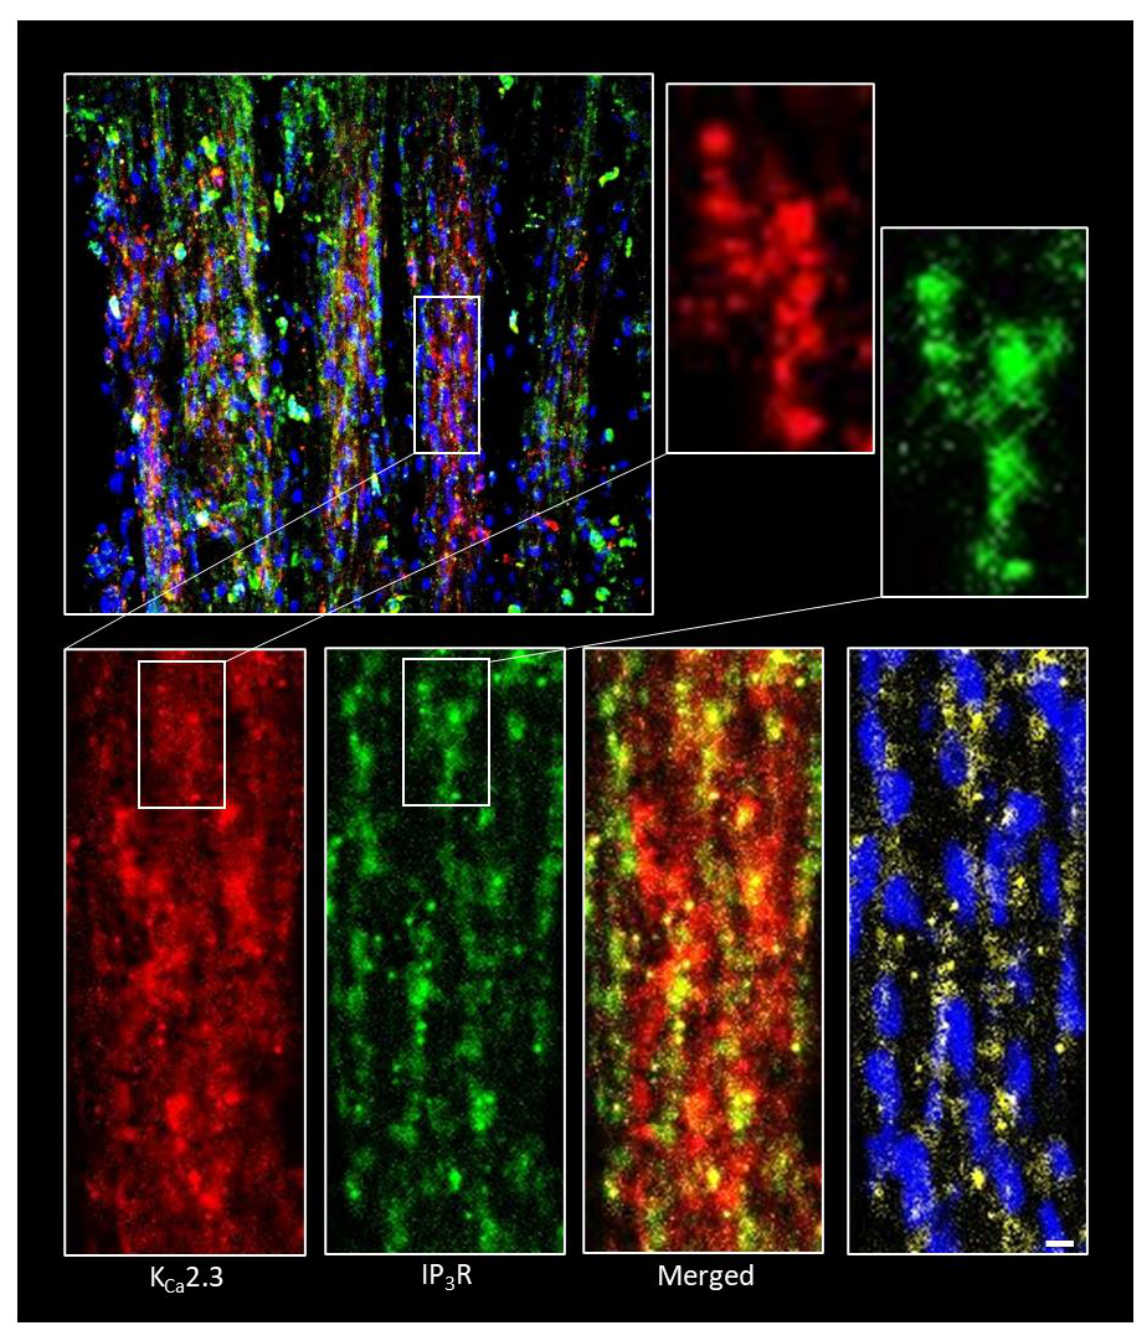
Figure 4. Expression of K Ca 2.3 and IP 3 R in mouse myometrium. The upper left panel shows immunofluorescence staining of K Ca 2.3 channels (red) and IP 3 Rs (green) in a longitudinal strip of mouse myometrium; cell nuclei are blue. The boxed region is expanded (bottom left) to show distinct K Ca 2.3 and IP 3 R staining patterns; insets show zoom of the designated regions. The merged image reveals regions of overlapping K Ca 2.3 and IP 3 R densities. The lower right panel highlights overlapping K Ca 2.3 and IP 3 R-positive signals (yellow); cell nuclei are included for reference. Images are representative of tissue preparations from three animals. Scale bar 10 µm.